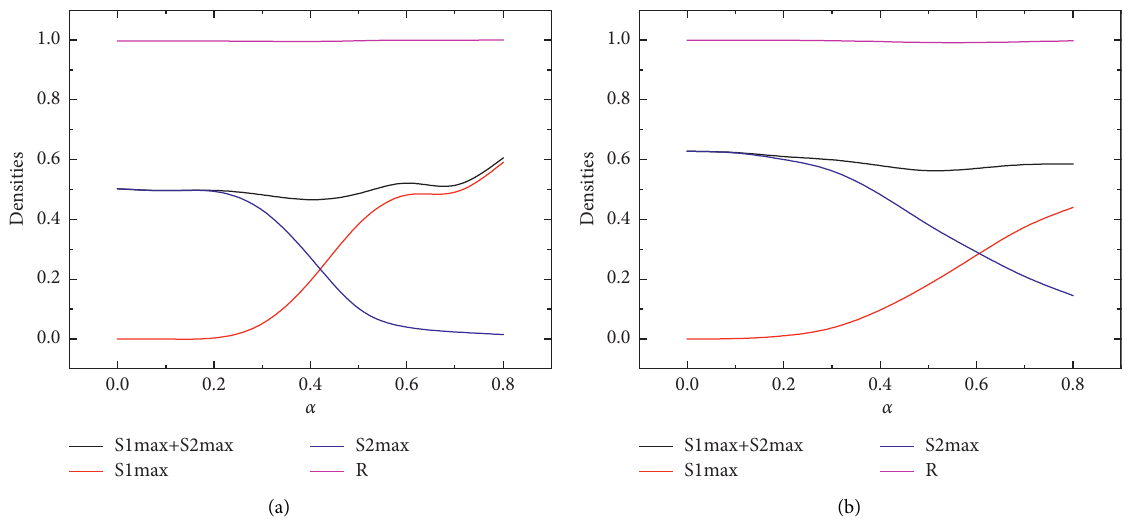
Figure 6: The influence of different values of α on rumor spreading. (a) WS small-world network. (b) BA scale-free